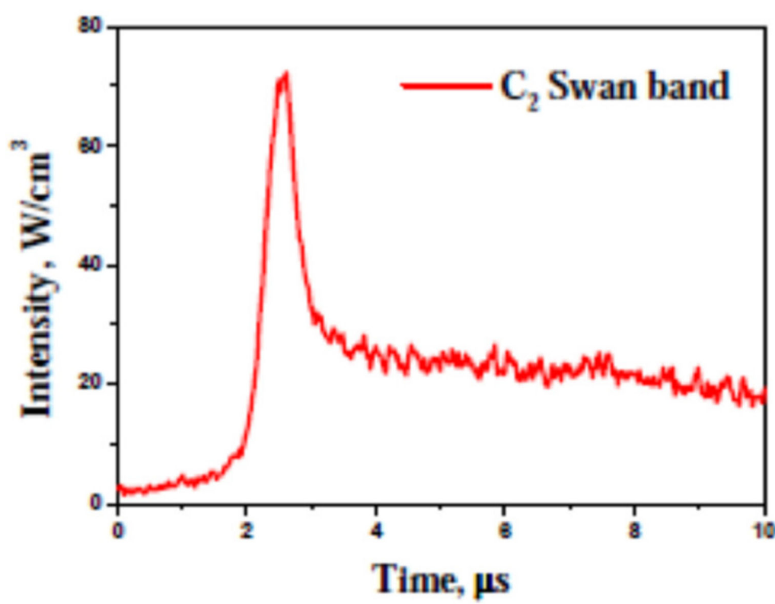
Figure 59. C 2 Swan band for Case 5 of Table 6 (from [55]).